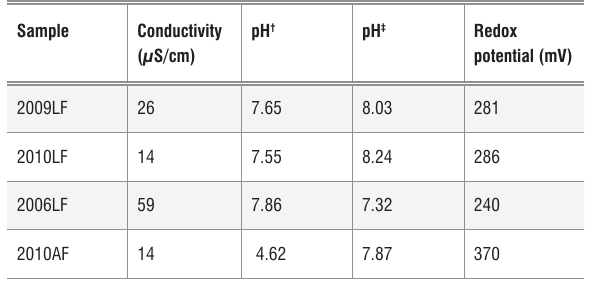
Table 2: Properties of the soils in which the moringa plants were